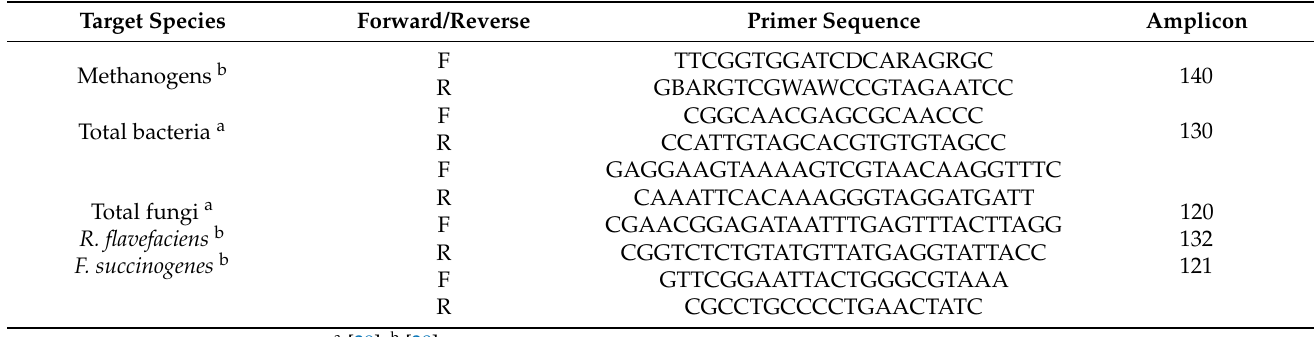
Table 2. PCR primers for real-time PCR